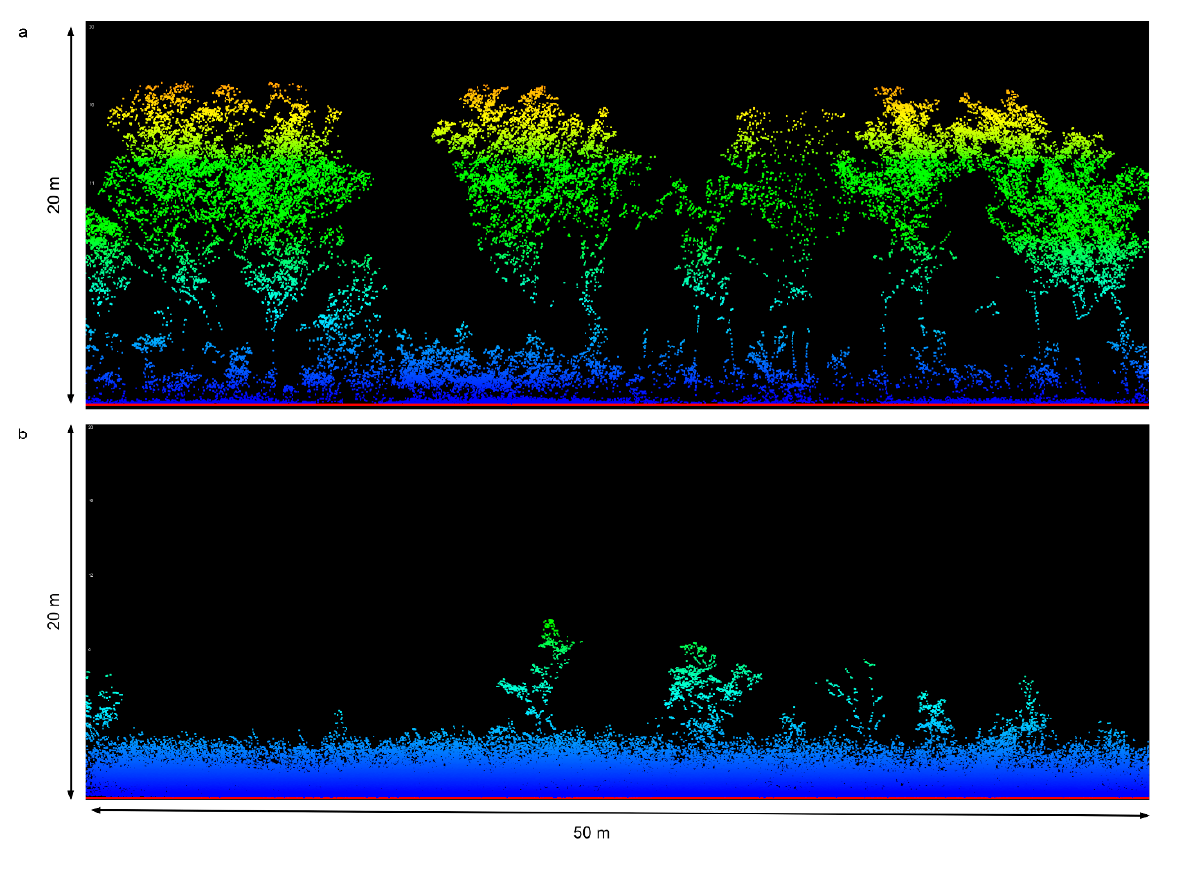
Figure 3. Cross-section through the collected LiDAR point cloud, normalised to height above ground level, in ( a ) a native vegetation site, and ( b ) a A. gayanus invaded site. The width of the point cloud cross-section is 10